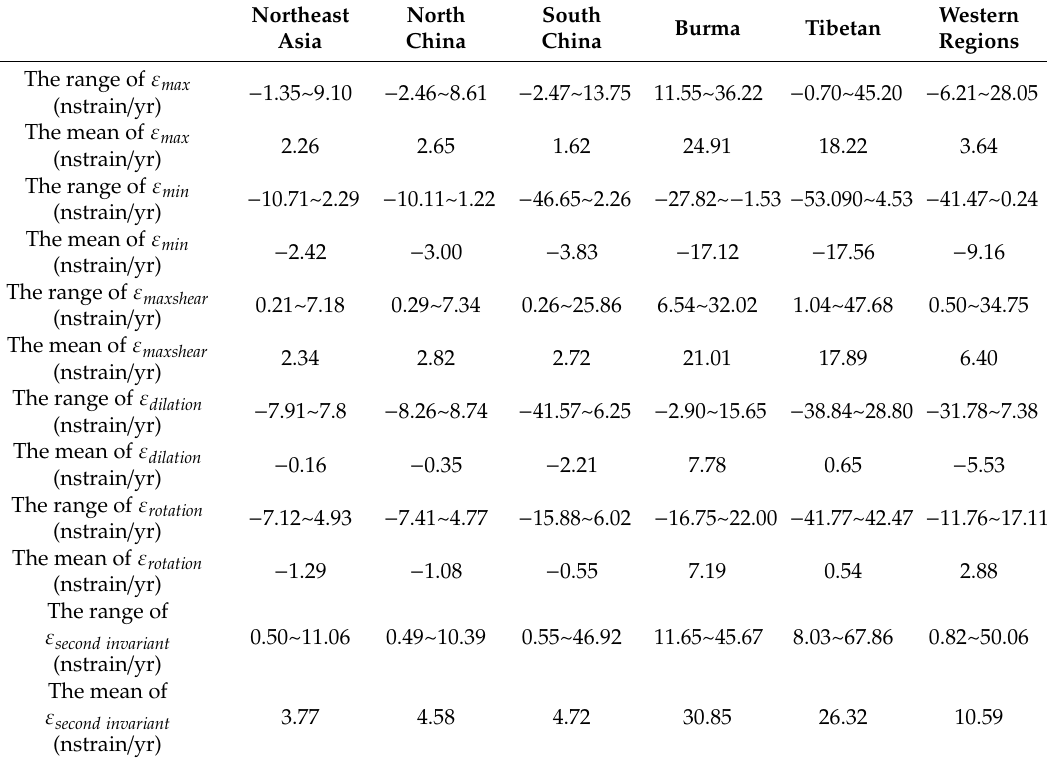
Table 2. The range and mean value of the strain rate index of first-grade blocks in continental